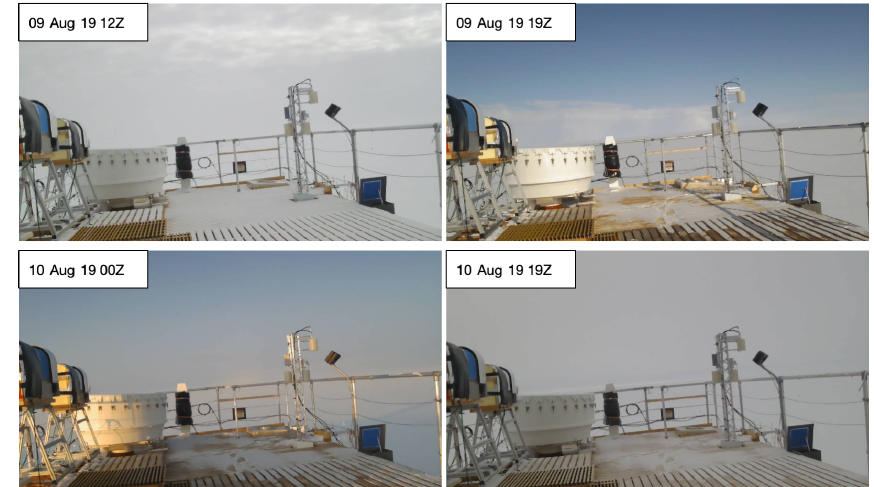
Figure 14. Photographs from a webcam oriented towards the eastern horizon on 9 and 10 August 2019. The aerosol inlet is visibly mounted on the mast in the SE corner.